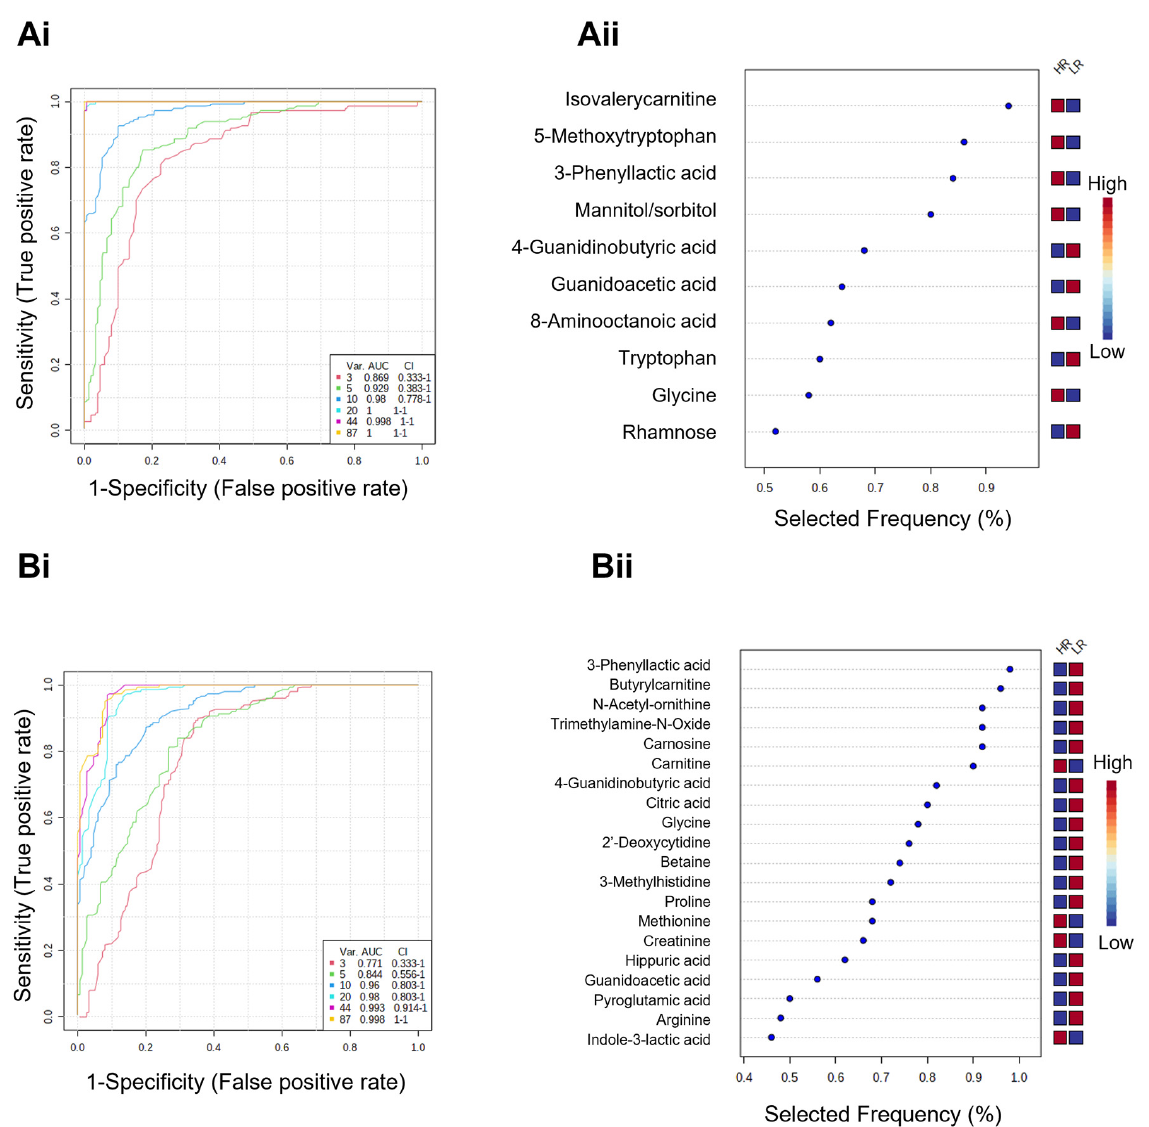
Figure 7. Partial least-squares discriminant analysis (PLS-DA) receiver operating characteristics (ROC) curve and loading plots for significant metabolites discriminating high-responders (HR) and low-responders (LR). Models were generated using datasets comprising ( A ) untreated control and ( B ) drug combination-treated PDE cultures at day 14. ( i ) ROC plots showing area under the curve (AUC) for the models based on different number of features (3, 5, 10, 20, 44 and 87). ( ii ) Frequency percentage plot of the dysregulated metabolites in HR vs. LR in each dataset based on ( A ) 10 and ( B ) 20-features